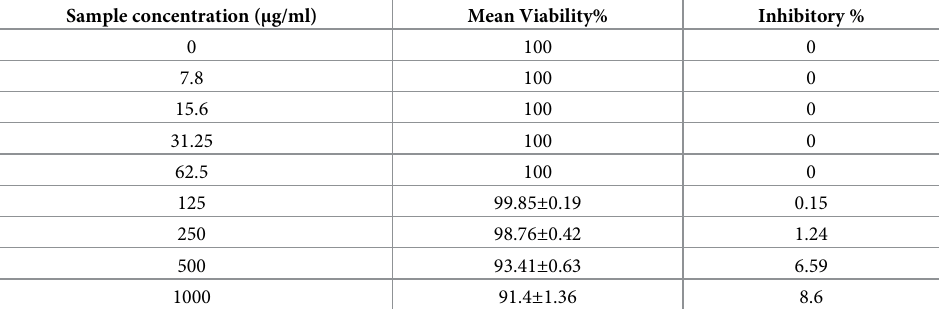
Table 1. Evaluation of cytotoxicity of Se-NPs against Rat hepatocytes cell line by MTT assay. Values are expressed as mean ± SE.